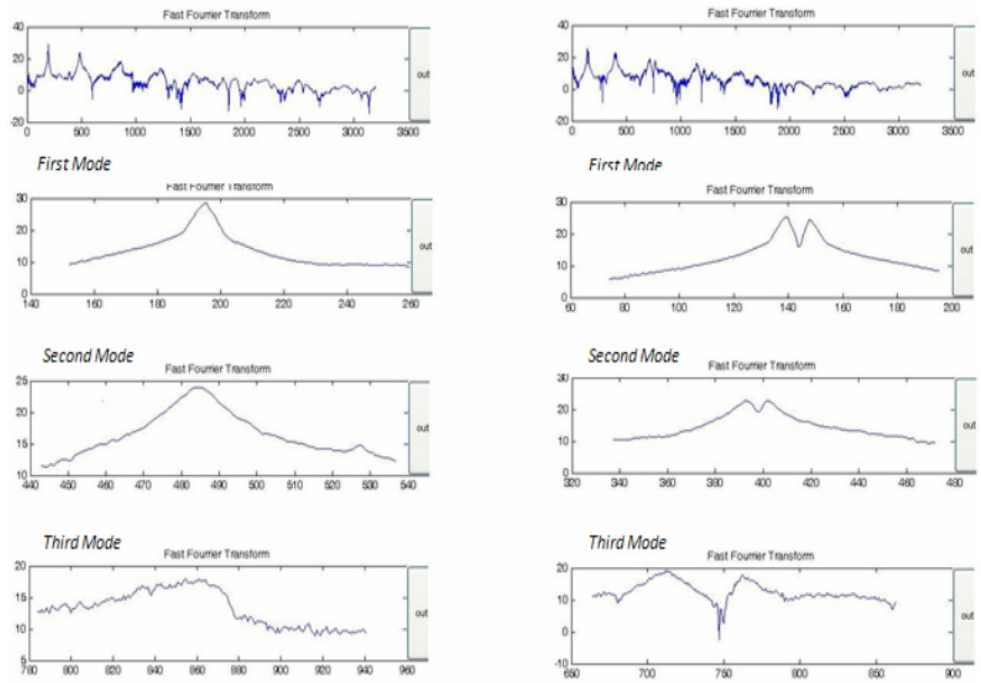
Fig. 4. Fast Fourier Transform spectra for knot-free (Left) and knot-containing (Right) beams. Modes of vibrations in FFT spectrums of knot-free specimens were pick-like, symmetric, and without any breaks, but knot-containing samples yielded entirely asymmetric